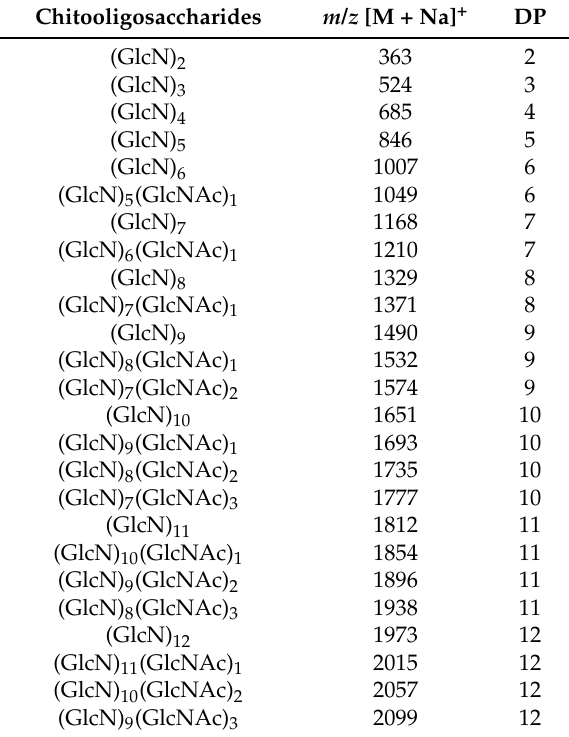
Table 5. MALDI-TOF-MS data for COS technical